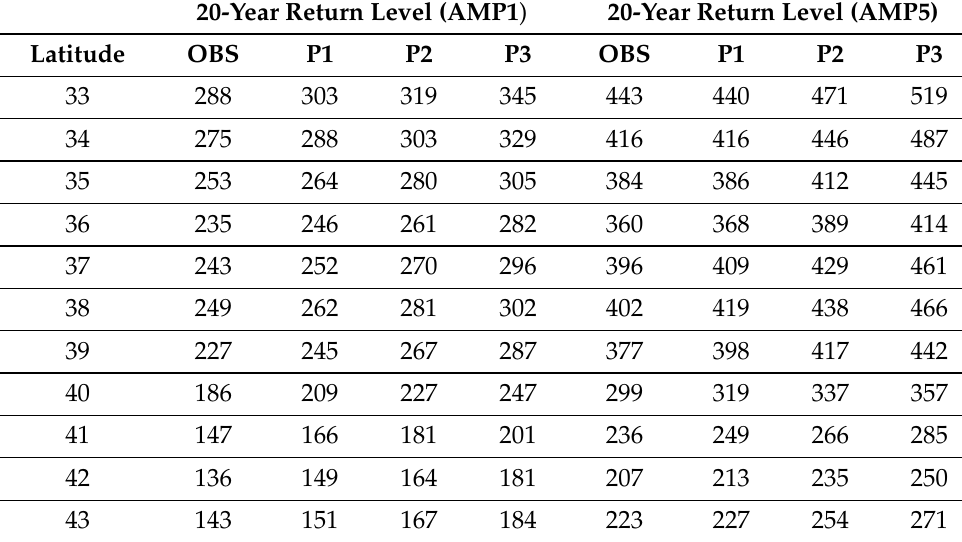
Table 3. The 20-year return levels (unit: mm) of the annual maximum daily precipitation (AMP1) and of the annual maximum five-day precipitation (AMP5) averaged over each latitude for the observations (OBS) during 1973–2010 and for future periods—namely, P1 (2021–2050), P2 (2046– 2075), and P3 (2071–2100). For each future period, the values were averaged over the three